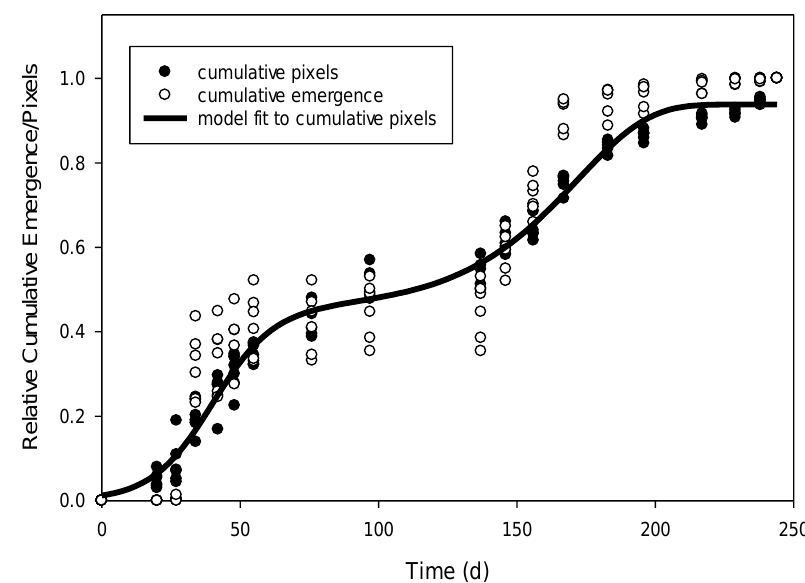
Figure 1. Relative cumulative pixels over time in days (dark circles). A biphasic equation was needed to fit the data as a predictive model for emergence of Raphanus raphanistrum (solid line). The relative emergence over time was based on true counts (white circles). None of the true count data were used to create the predictive model. Table 3. Predictive model of R. raphanistrum emergence fit to relative cumulative pixels over time. Predicted values were regressed with observed pixel values used to create the model (RMSE and R 2 ) and for validation, with relative cumulative emergence of true counts (RMSE validation).